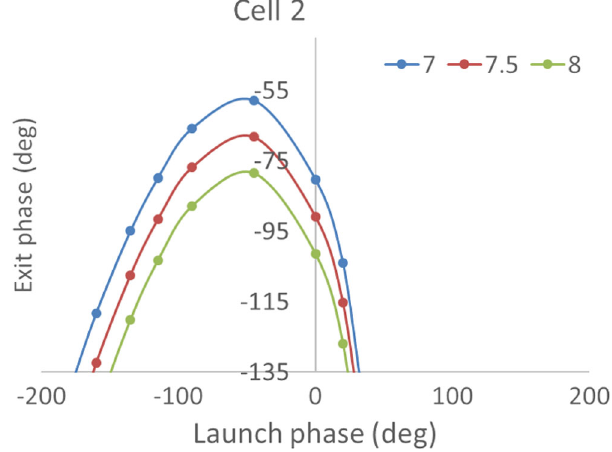
FIG. 4. Arrival phase at the exit of the second cell as a function of the electron launch phase from the cathode, for differing lengths of the second cell.